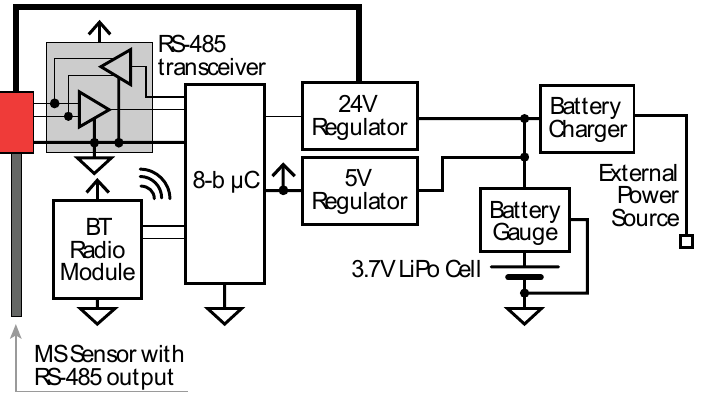
Figure 2. Architecture of the electronic part of the sensor node. The wireless module can be substituted with other types of modules by simply changing the microcontroller